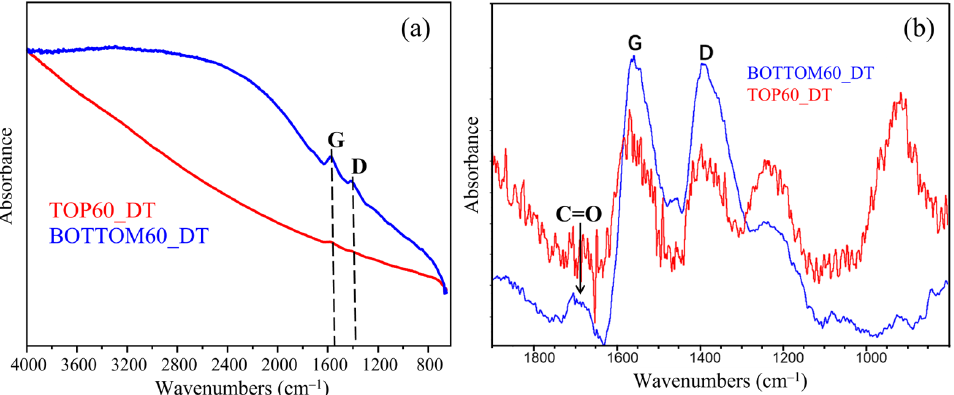
Figure 6. Normalized FTIR spectra of TOP60 and BOTTOM60 obtained in double transmission: ( a ) Spectra, as recorded; and ( b ) Spectra after baseline correction.